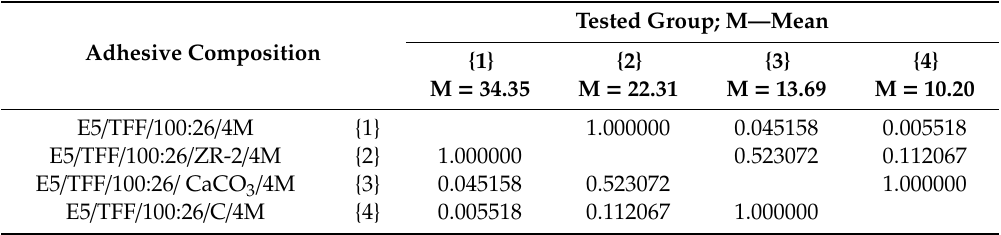
Table 10. The Kruskal–Wallis rank test results of the strength of the adhesive compositions from the E5 / TFF / 4 month group.